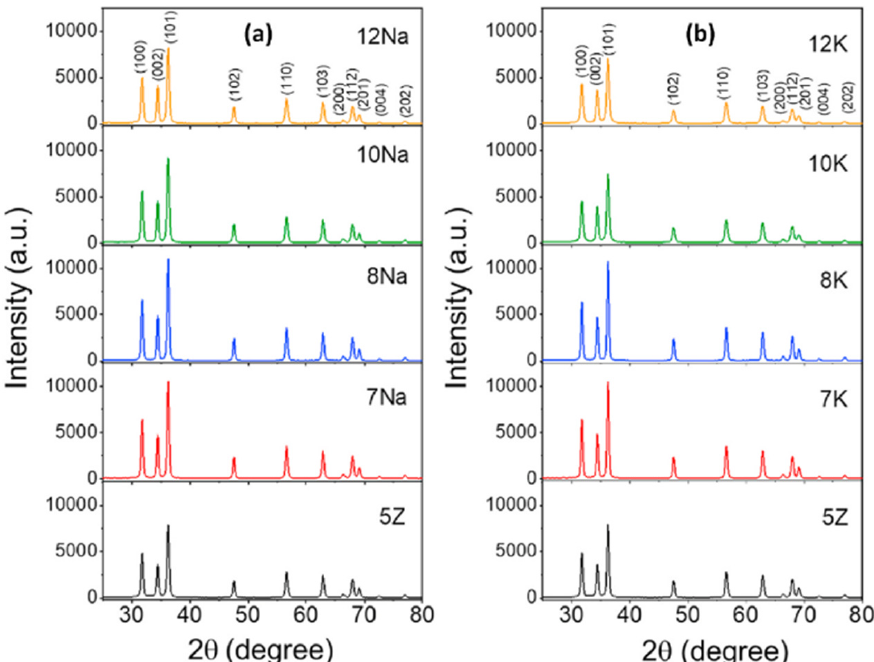
Figure 4. Typical XRD patterns of ZnO nanostructures synthesized with different reaction pH (( a ) NaOH and ( b ) KOH as pH controlling agents, 7, 8, 10, 12 correspond to their respective concentrations). Reprinted/adapted with permission from Ref. [65]. Copyright © 2022, Elsevier Ltd. and Techna Group S.r.l.